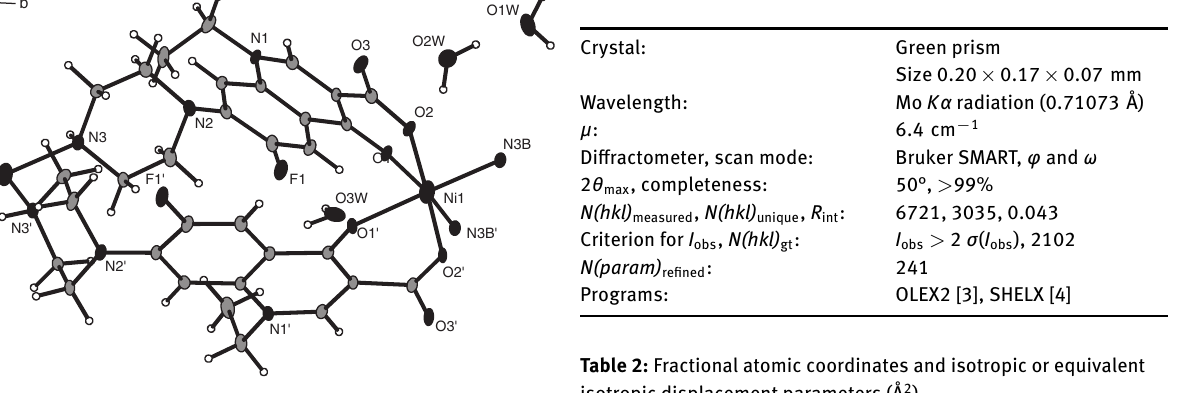
Table 2: Fractional atomic coordinates and isotropic or